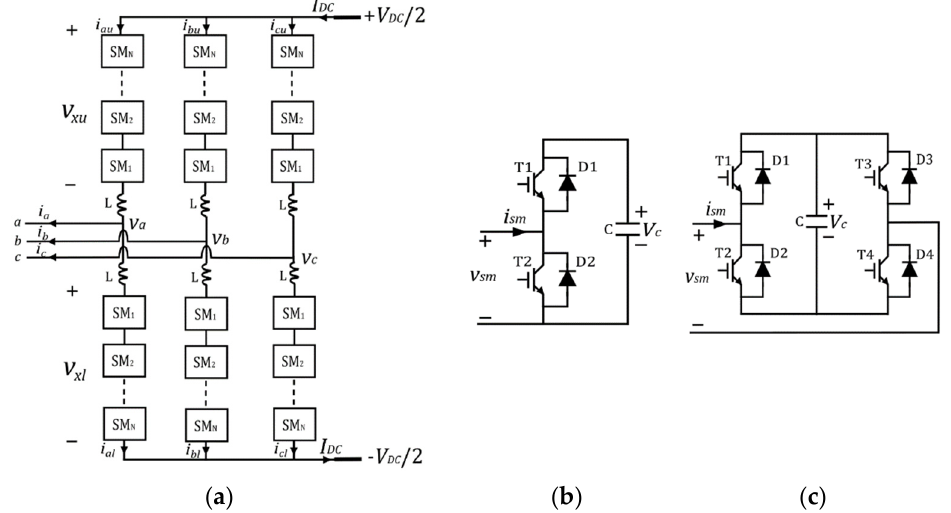
Figure 1. ( a ) Structure of a three-phase MMC; ( b ) the Half-Bridge SM (HBSM); ( c ) the Full-Bridge SM (FBSM).